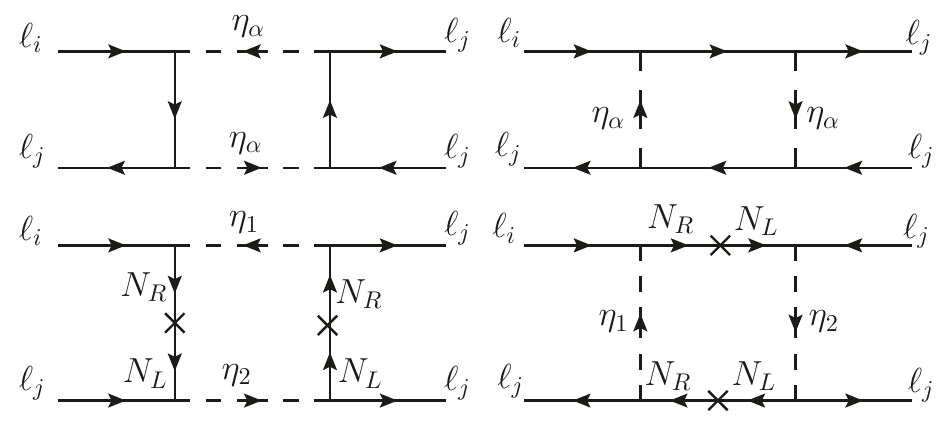
Figure 3 . Selected box diagrams for ‘ i → 3 ‘ j